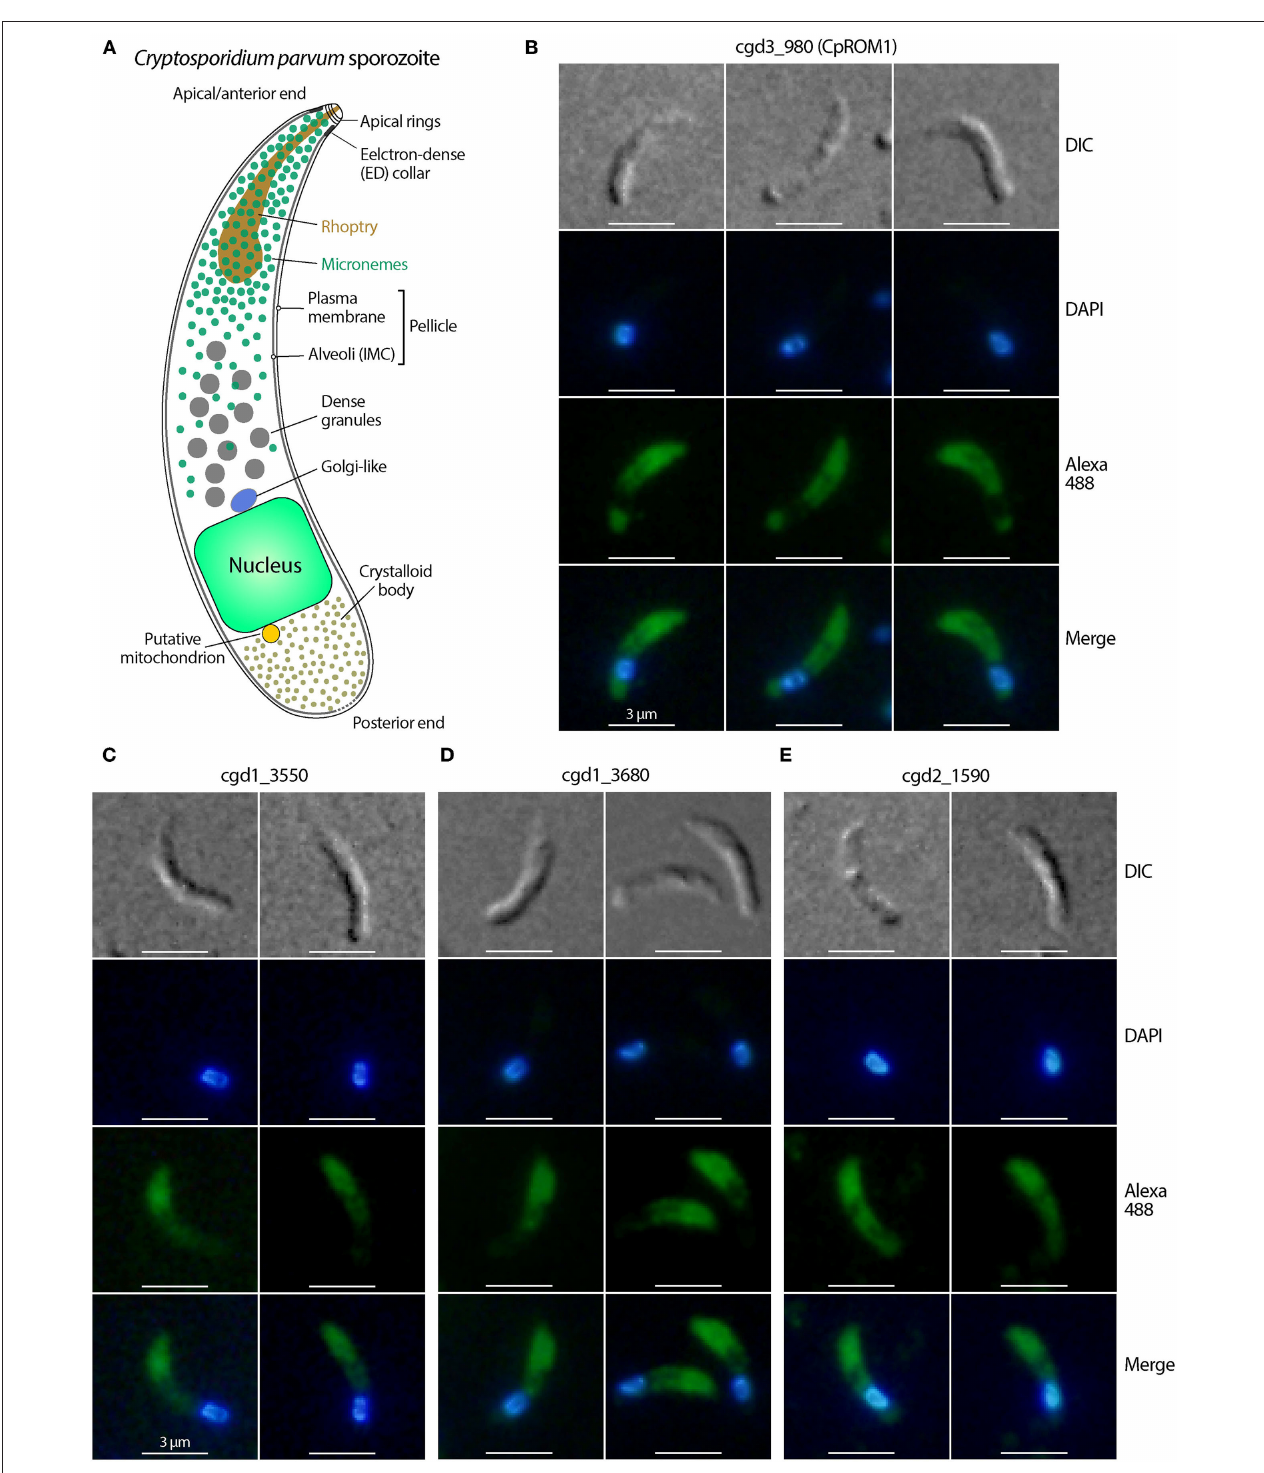
FIGURE 1 | Immunofluorescence micrographs of the four Cryptosporidium parvum proteins likely located in sporozoite micronemes. (A) Structural illustration of C. parvum sporozoites showing the distributions of secretory organelles (micronemes, rhoptry, and dense granules). (B–E) Immunofluorescence assays (IFA) of C. parvum proteins cgd3_980 (CpROM1; Peptidase S54 rhomboid domain containing protein), cgd1_3550 (Apple domain-containing protein), cgd1_3680 (EGF-like domain containing protein), and cgd2_1590 (Apple/EGF-like/Apple domain-containing extracellular protein) in sporozoites. All four proteins showed fluorescence distribution in the anterior third of the sporozoites corresponding to the distribution of micronemes, but varied in signal distribution in other areas of the sporozoites. Proteins were labeled with Alexa Fluor 488 (green) and the nuclei were stained with 4,6-diamidino-2-phenylindole (DAPI) (blue). The morphology of sporozoites was determined using differential interference contrast microscopy